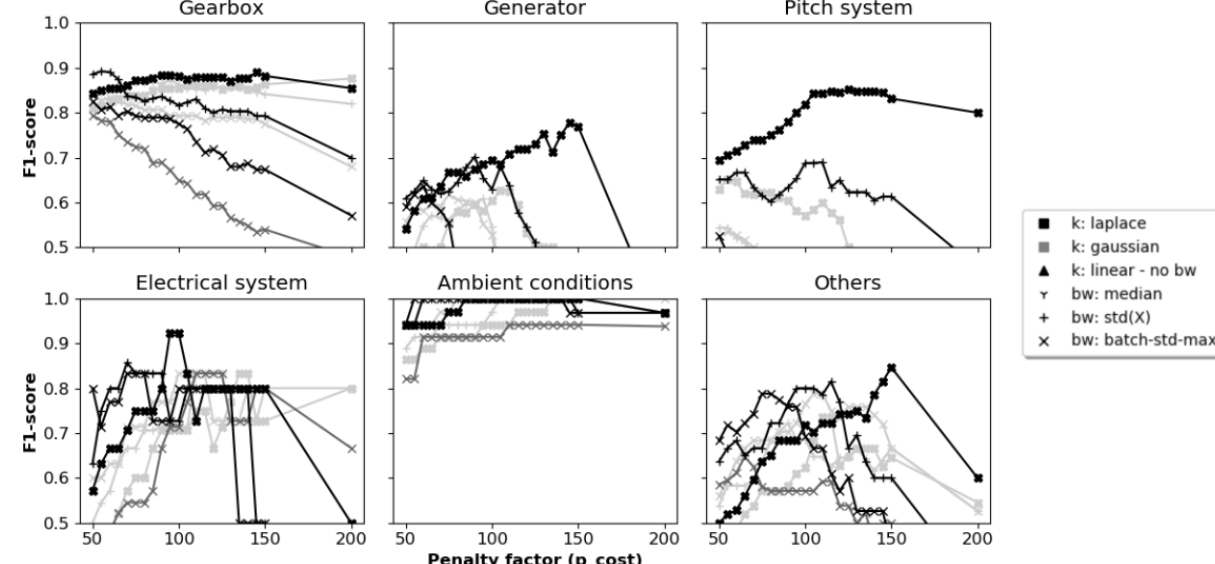
Figure C1. The 2-year signal validation: F1 scores per component for different hyperparameter configurations and penalty values.